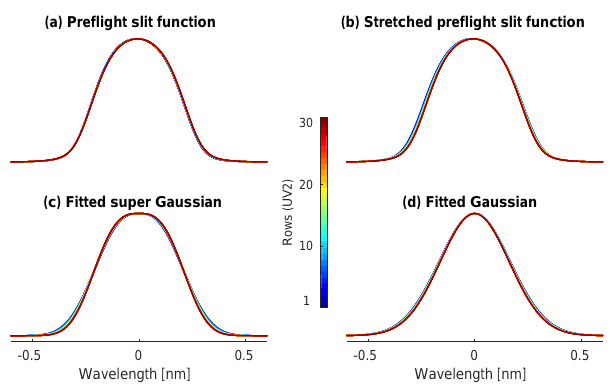
Figure 2. (a) Preflight slit functions at the median wavelength of the spectral window 343–356nm (349 . 5nm). The spectral variations of preflight slit functions over this window are small (see the second row of Fig. 3 for the range of preflight slit function width in UV2). (b–d) Derived slit functions for the spectral window 343–356nm by fitting a stretch factor to the preflight slit function, super-Gaussian function, and standard Gaussian function, respectively. The solar spectrum used in the fitting is the average OMI irradiance from 2005 to 2007. Adding the asymmetric parameter in the super/standard Gaussian fitting gives little difference. Only half of the UV2 cross- track positions (1–30) are shown as the other half are essentially a mirror image (see the second row of Fig.